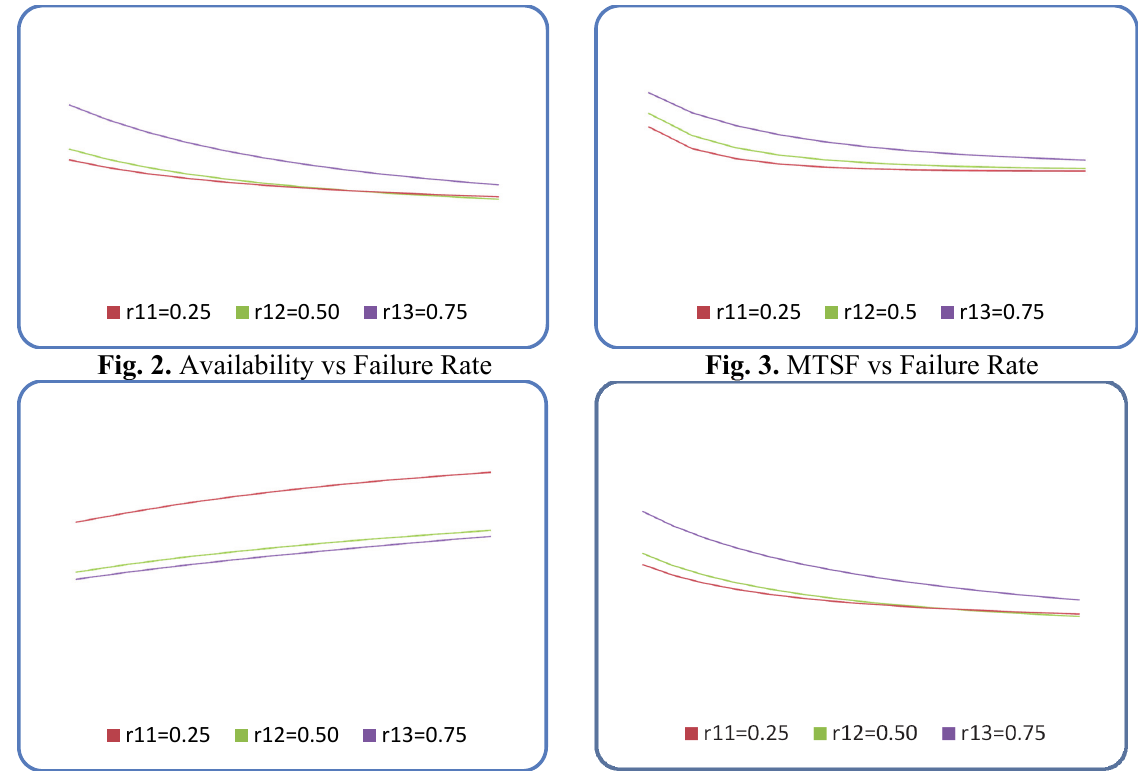
Fig. 2. Availability vs Failure Rate Fig. 3. MTSF vs Failure Rate